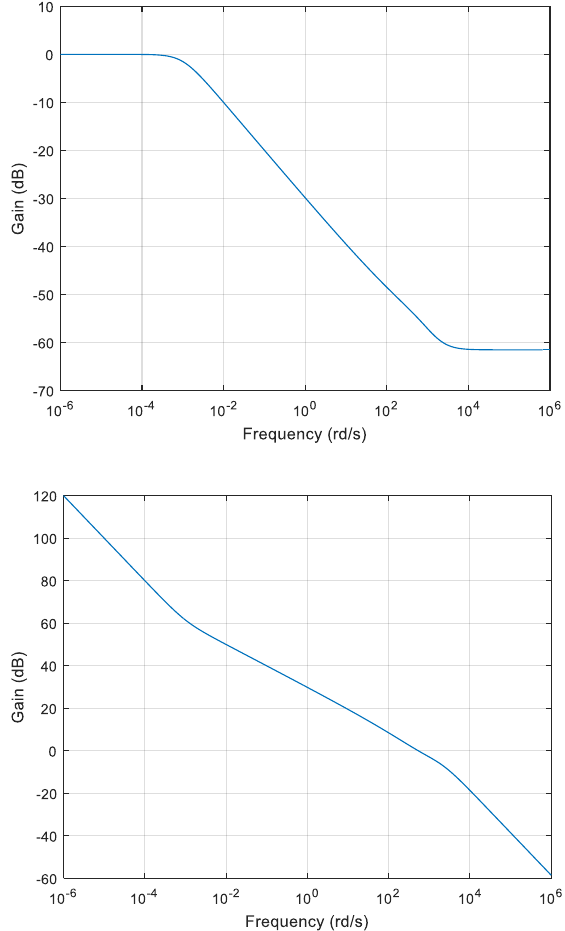
Figure 1. Gain diagrams of transfer functions 𝜂 5 (𝑠) (up) and 𝐻 5 (𝑠) (down) with 𝜔 𝑚𝑖𝑛 = 0.001 rd/s, 𝜔 𝑚𝑎𝑥 = 1000 rd/s, and 𝜈 = 0.5 .